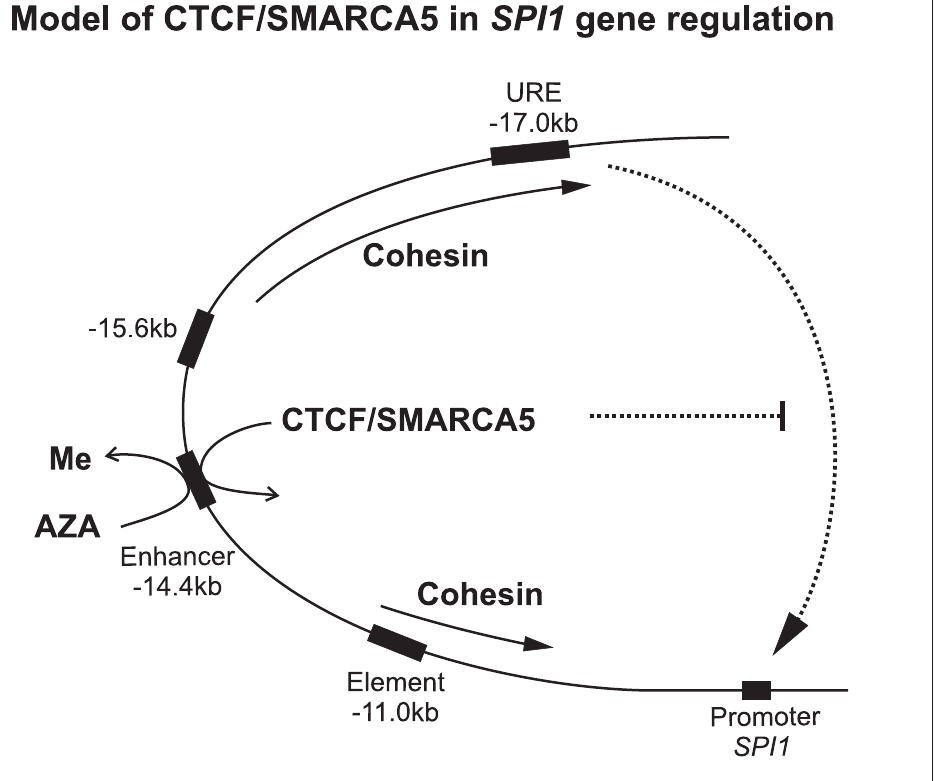
Figure 8. Model of epigenetic regulation of SPI1 gene by CTCF and SMARCA5. CTCF binding site ( 2 14.4 kb) becomes occupied by CTCF and SMARCA5 upon AZA-mediated DNA demethylation in AML blasts. Cohesin member’s recruitment partially overlaps with CTCF/SMARCA5 and display spreading over 2 11.0 kb and URE of SPI1 . More diffuse occupancy of both CTCF and SMARCA5 at SPI1 gene that was observed in mixed myeloid cells was not achieved in AML blasts, however the AZA treatment partially restored CTCF/SMARCA5 occupancy. Nevertheless, SMARCA5/ CTCF is unable to potentiate SPI1 derepression in AML blasts and instead, inhibits SPI1 transcription possibly through the enhancer-blocking effect at the 2 14.4 Enhancer.